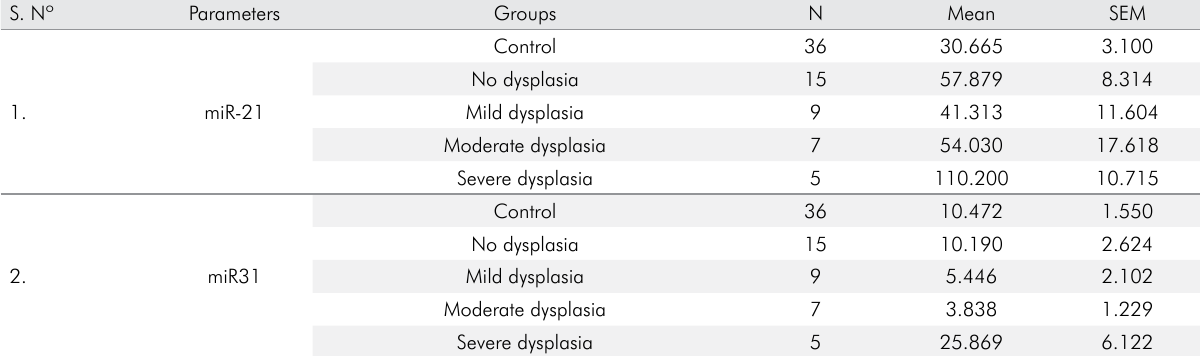
Table 2. Mean (SE) of fold difference of miRNA-21, miRNA-31 in various degrees of dysplasia. S. Nº